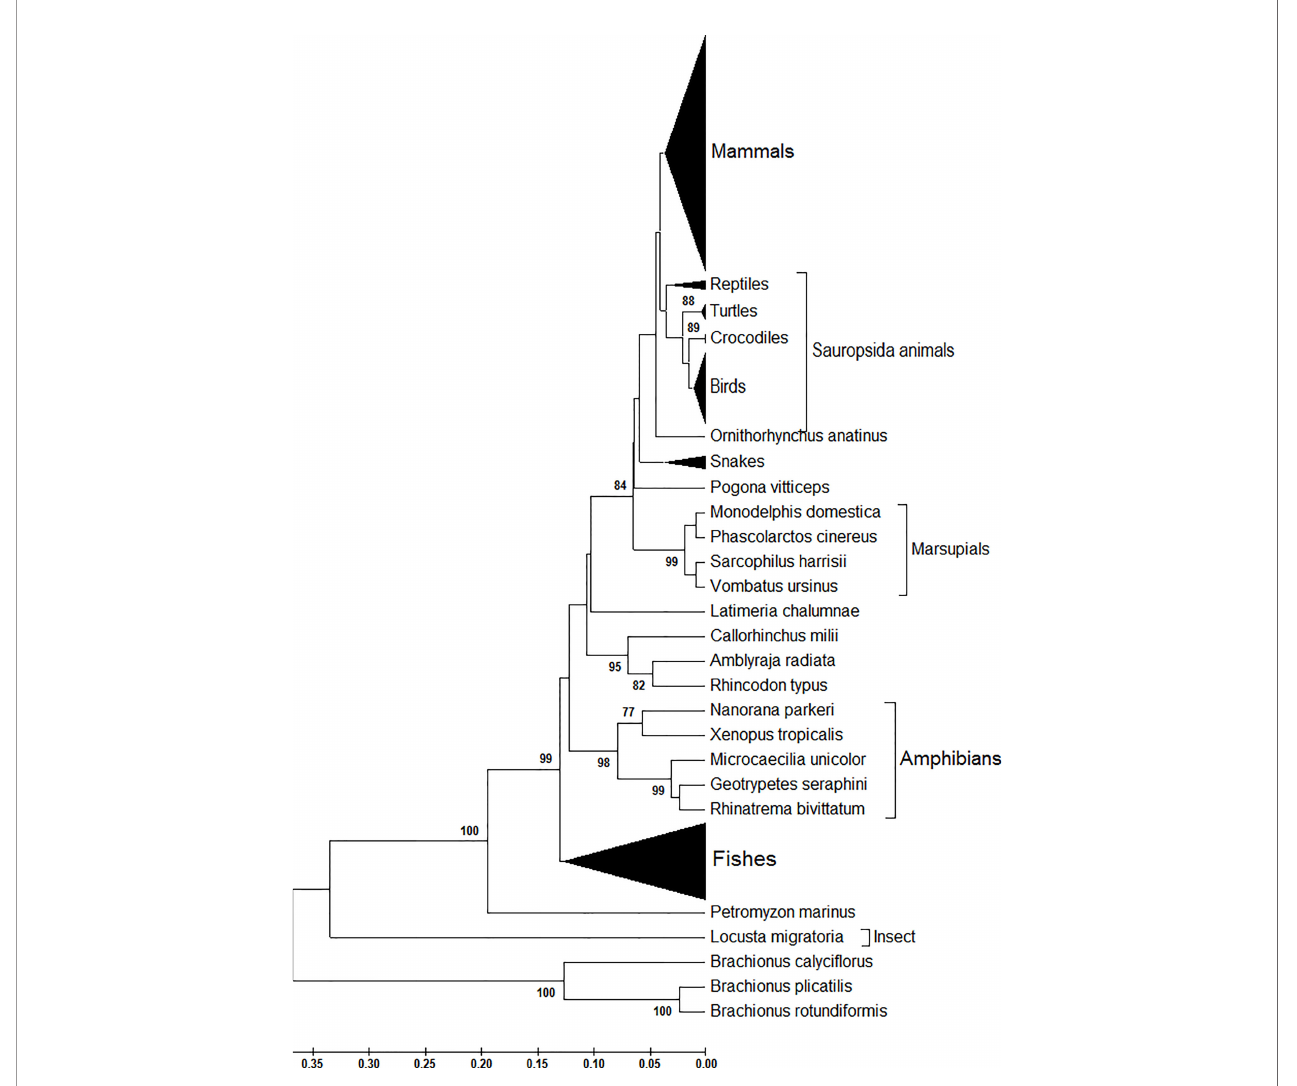
FIGURE 2 | Phylogenetic analysis of ATG13 protein sequences of 226 eukaryotic organisms. This phylogenetic tree was constructed by the Maximum Composite Likelihood model with UPGMA statistical method at the nucleotide level. Branches leading to these groups of sequences were supported by 100% of bootstrap replications in all